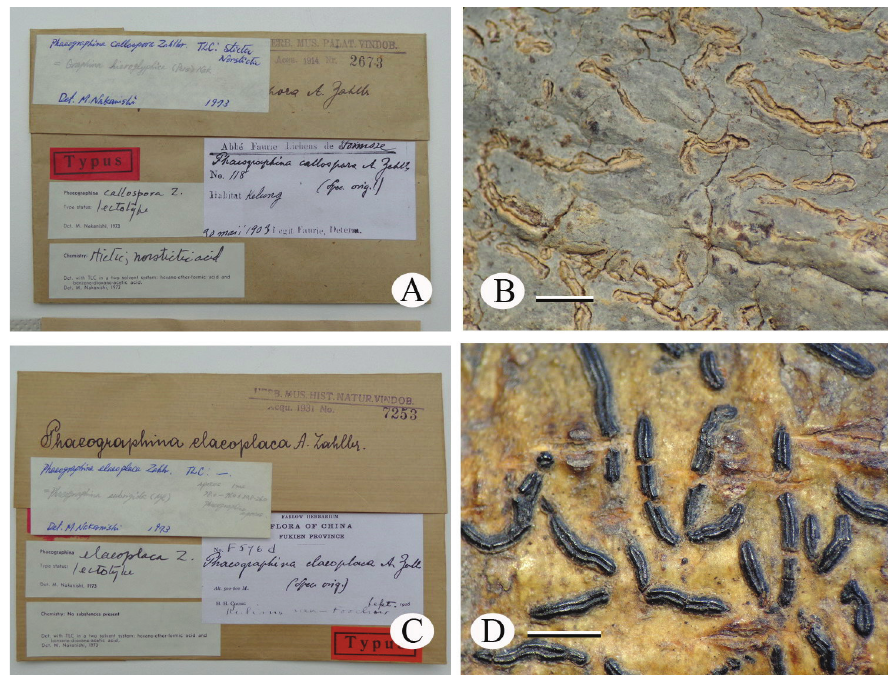
Figure 1. A–B Phaeographina callospora Zahlbr. ( Faurie 118 ) C–D Phaeographina elaeoplaca Zahlbr. ( Chung 596d ). Scale bars: 1mm.